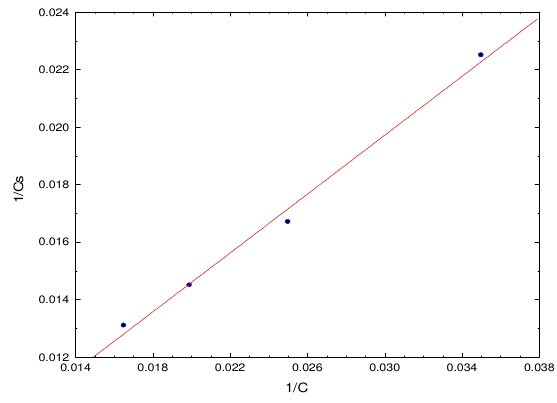
Fig. 25. Plot the concentrations according to Langmuir adsorption isotherm for COD.